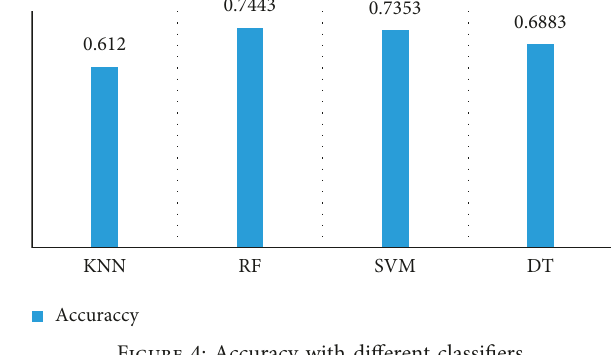
Figure 4: Accuracy with different classifiers.